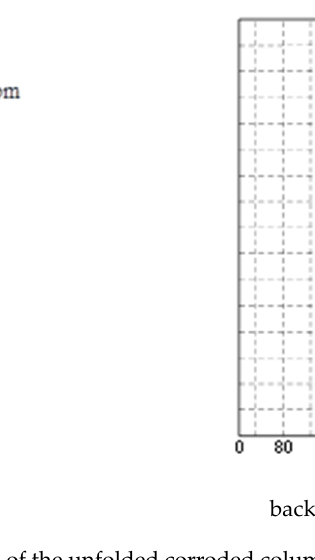
Figure 7. Diagram of the unfolded corroded